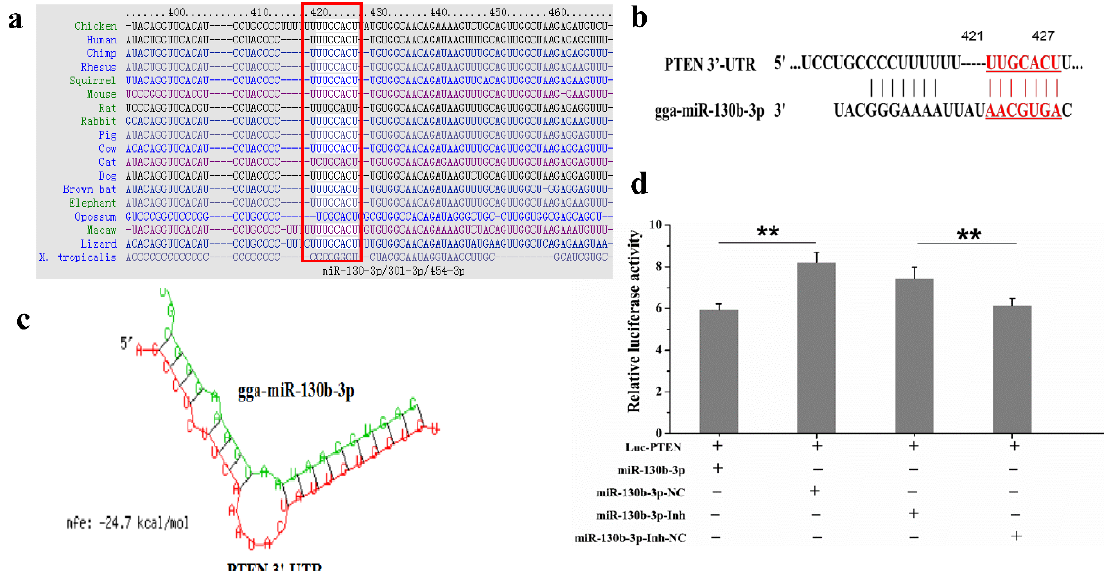
Figure 4. PTEN was a direct target of miR-130b-3p in DF-1 cells. ( a ) Prediction of conservation of the PTEN 3′-UTR in different species by TargetScan. The conserved target sequences are highlighted. ( b ) Prediction of binding site for miR-130b-3p from the PTEN 3′-UTR. The binding domain from position 421 to 427 is highlighted red. ( c ) Prediction of the secondary structure of the RNA duplex between miR-130b-3p and the PTEN 3′-UTR by RNAhybrid. ( d ) miR-130b-p directly targeted PTEN 3′-UTR in vitro. DF-1 cells cultivated in 24-well culture dishes were co-transfected Luc-PTEN (3′-UTR) with miR-130b-3p, miR-130b-3p-NC, miR-130b-3p-Inh, or miR-130b-3p-Inh-NC. 48 h after transfection, the cell lysates in each group were collected to test the relative luciferase activity by a microplate reader. All the Renilla luciferase activities were standardized by firefly luciferase activities. Values are expressed as mean ± SD. Each experiment group contained at least three duplicates. Each duplicate was measured at least three times. Marked differences are expressed as ** p < 0.01.